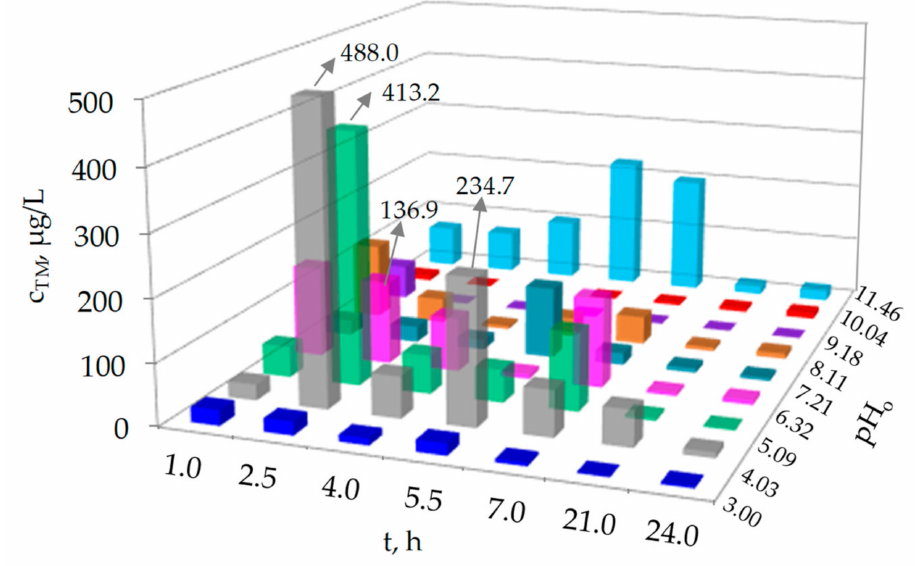
Figure 7. The concentration of the total mercury leached in soil suspensions at different pH o values in time intervals within 24 h. Note: the results after 24 h correspond to those given in Figure